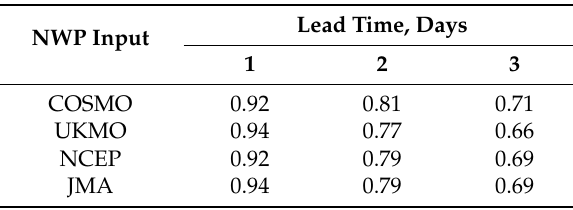
Table 2. Nash–Sutcliffe efficiency for operational inflow forecasts into the Zeya reservoir during 2015–2017 warm periods